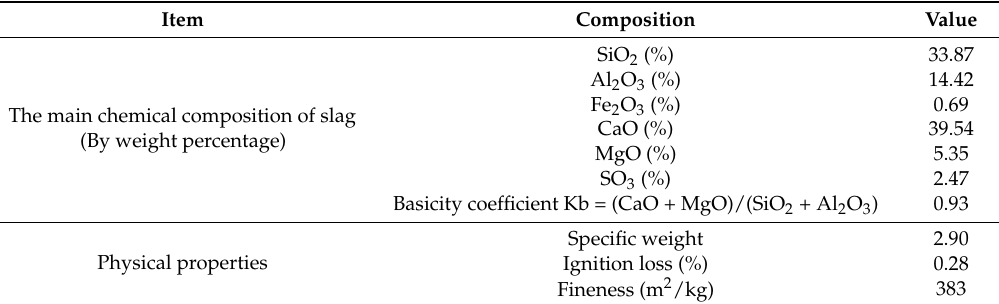
Table 1. The chemical and physical properties of slag.